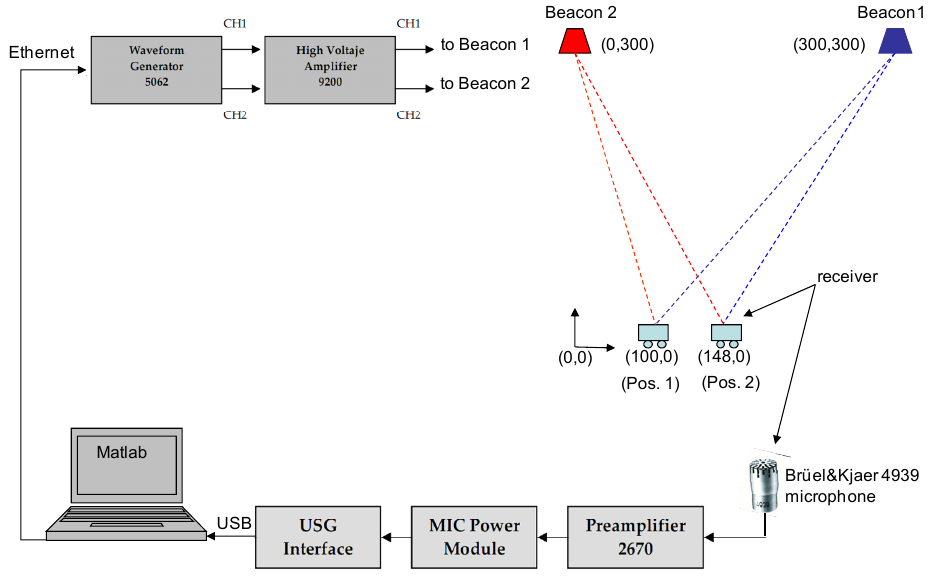
Figure 12. Experimental setup diagram.